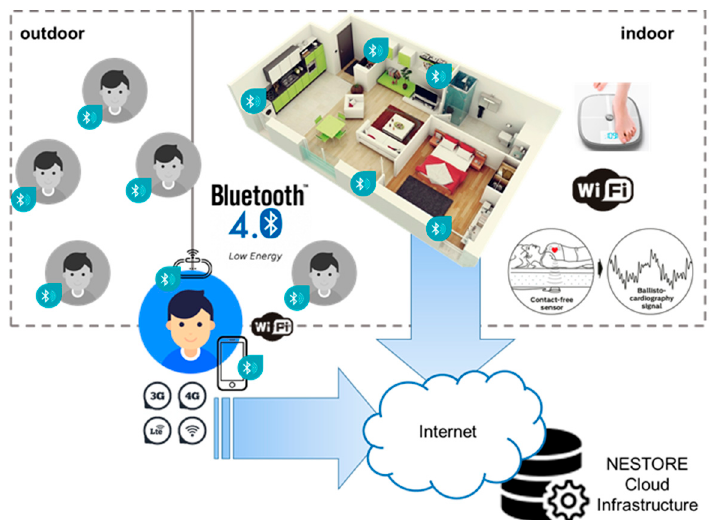
Figure 7. The data gathering and sensing Architecture.